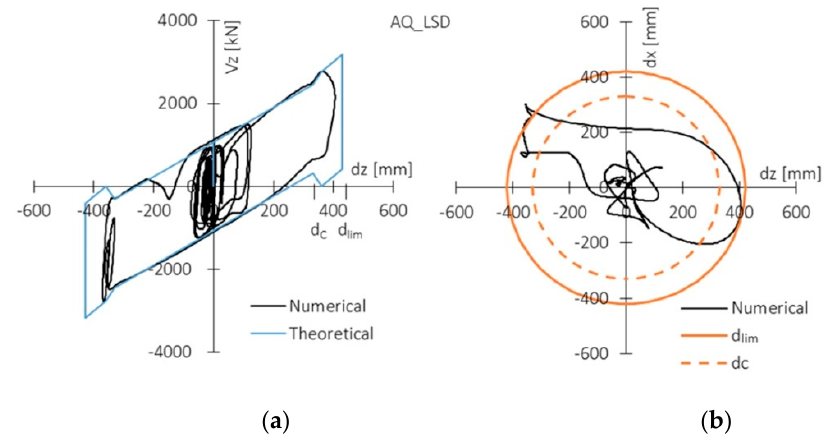
Figure 11. Results for an LLS (IM 6; EQ no. 2) intensity accelerogram on a force vs displacement diagram ( a ) and in plan view ( b ).